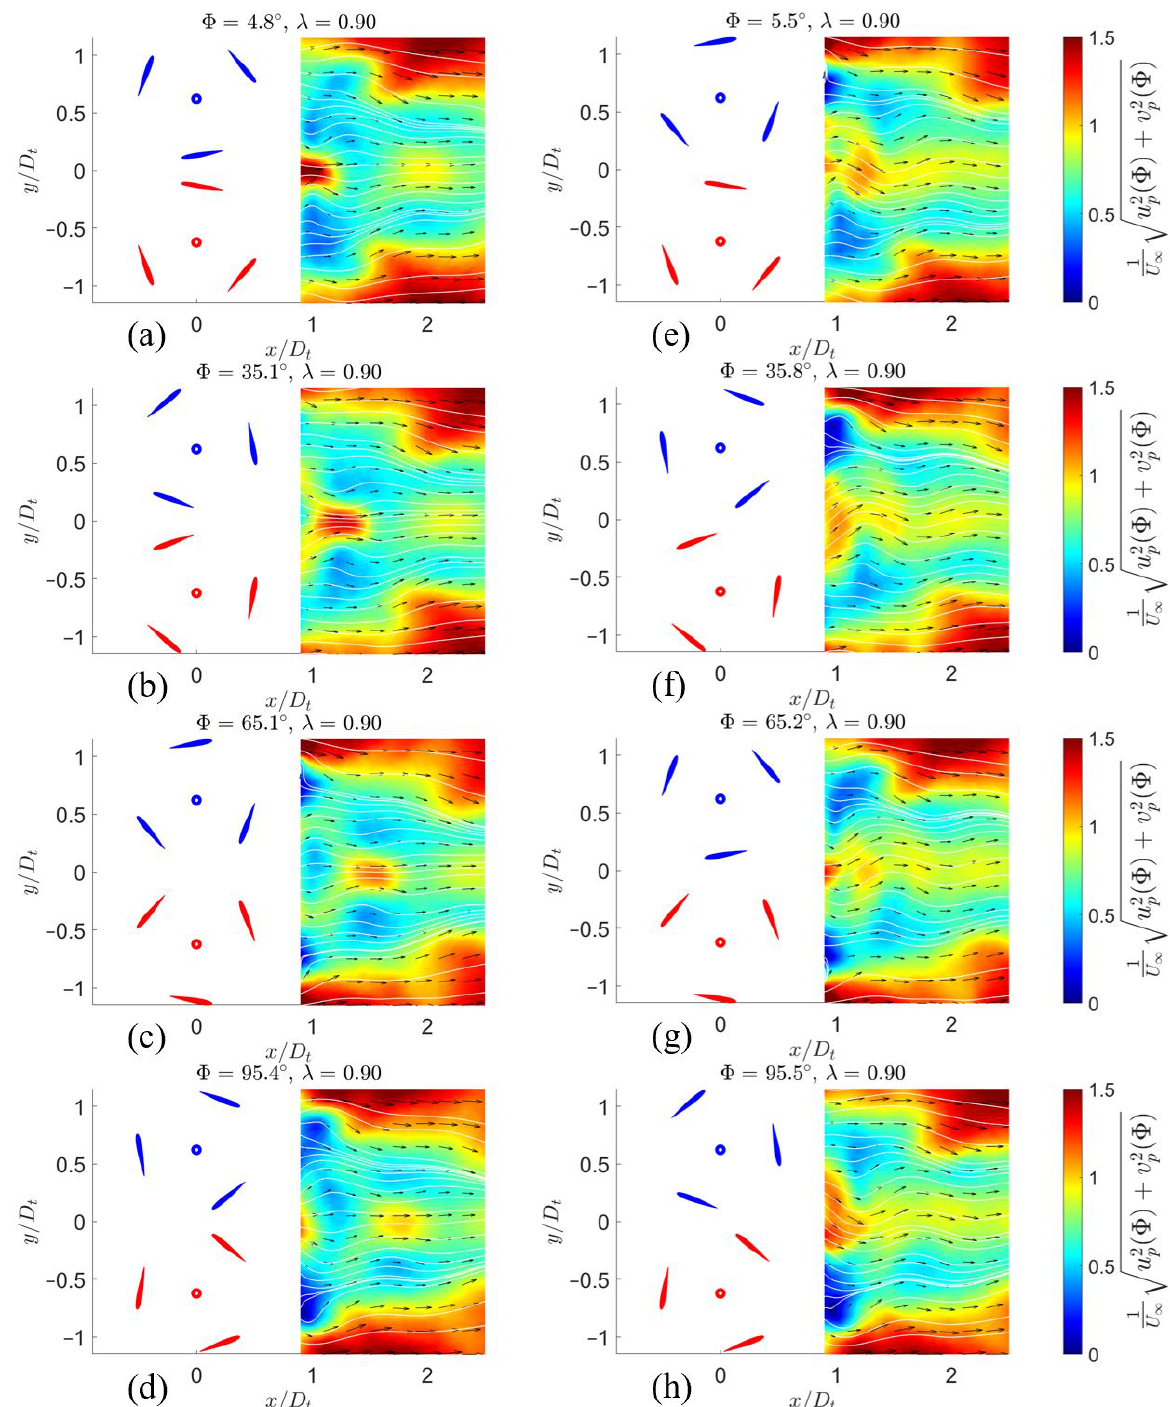
Figure 9. The phase-averaged flow fields behind the backward counter-rotating configurations at λ = 0.90. The power coefficients of these configurations are 0.108 and 0.103 for ∆Φ = 0 ◦ ( a – d ) and ∆Φ = 60 ◦ ( e – h ) correspondingly. The dis- played phase angles Φ belong to turbine T1 in red color. The color shows the non-dimensionalized phase-averaged velocity